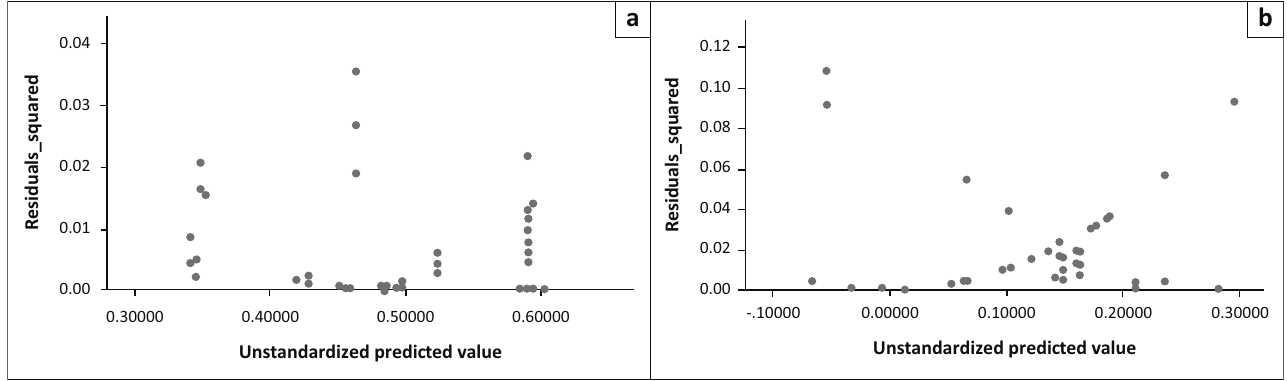
FIGURE 5: Linear residual plots (a) for wet resource state and (b) for dry resource state, indicating the presence of